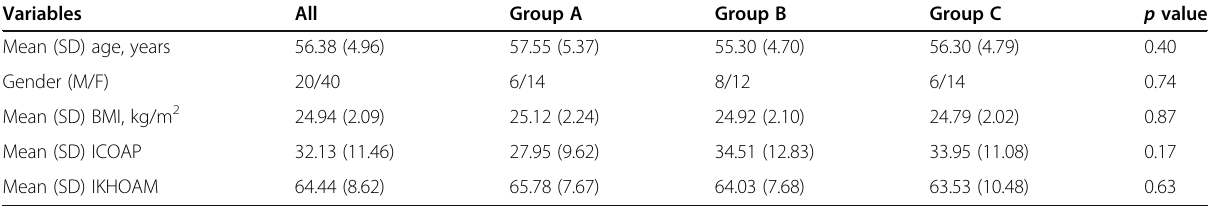
Table 1 Baseline characteristics of participants Variables